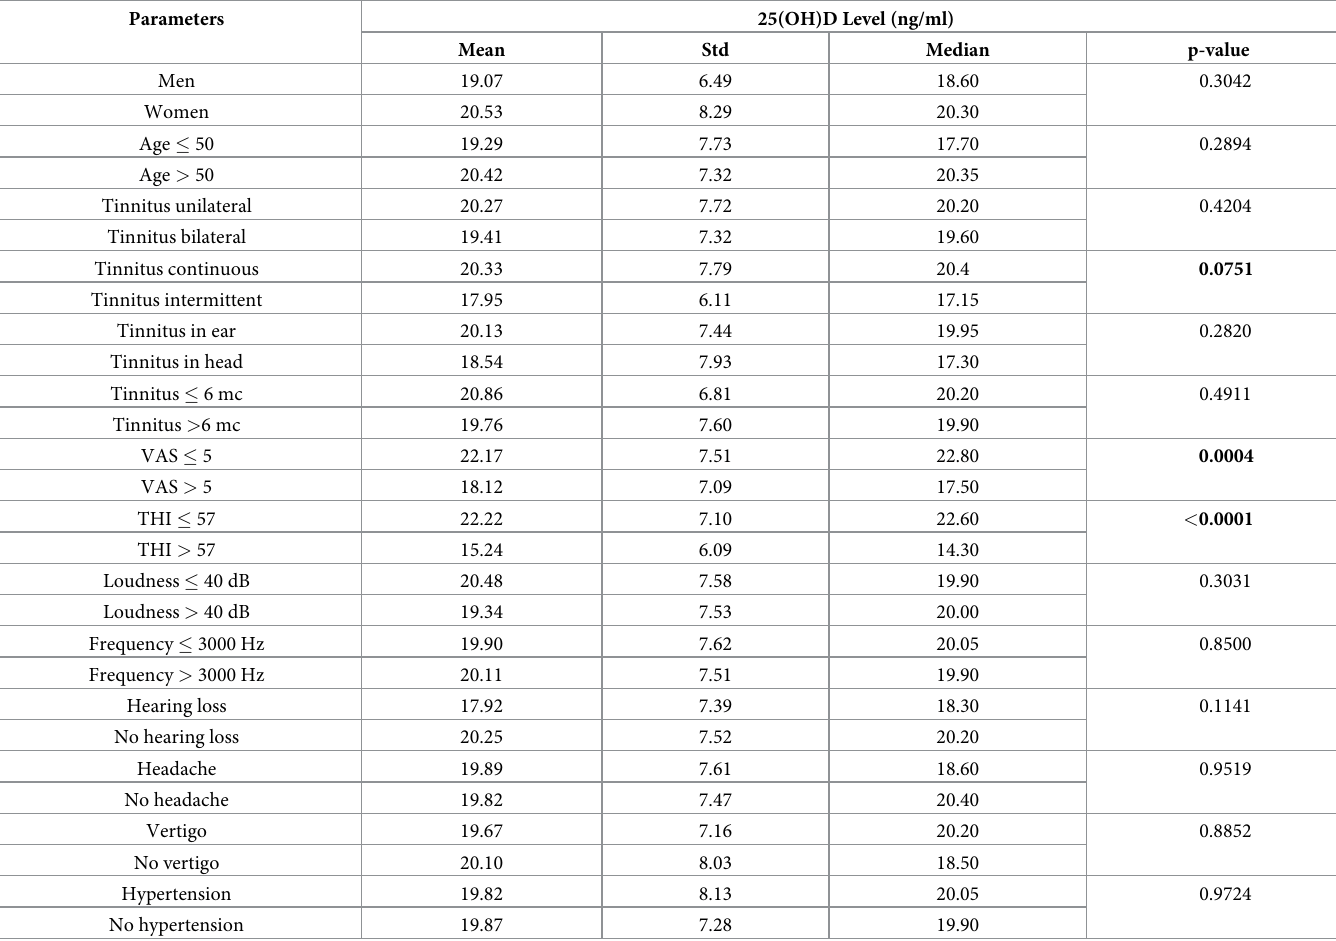
Table 3. Differences in the 25(OH)D level in tinnitus patients depending on gender, age, tinnitus parameters, and the presence of coexisting disorders.